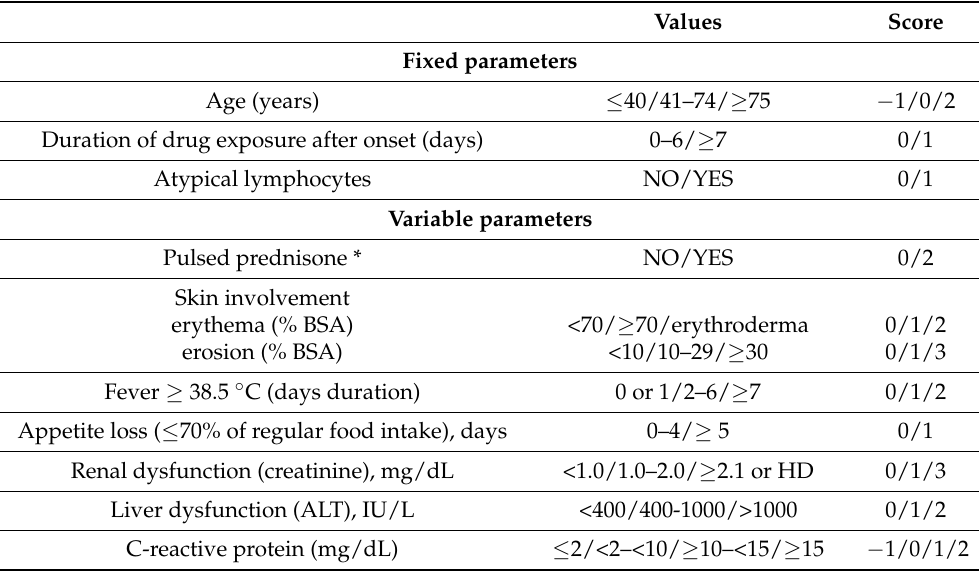
Table 6. Severity score of DRESS reaction. Table modified from Mizukawa et al. [10]. Values Score Fixed